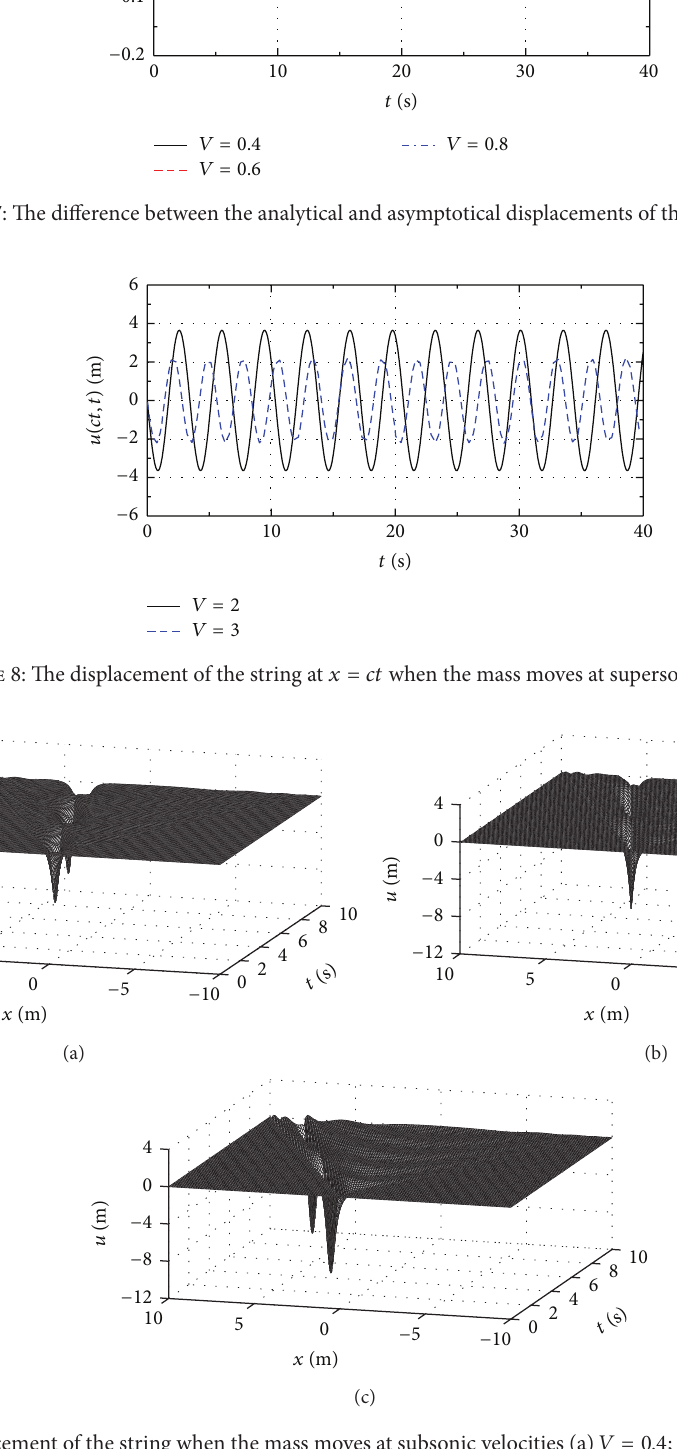
Figure 9: The displacement of the string when the mass moves at subsonic velocities (a) 𝑉 = 0.4 ; (b) 𝑉 = 0.6 ; and (c) 𝑉 = 0.8